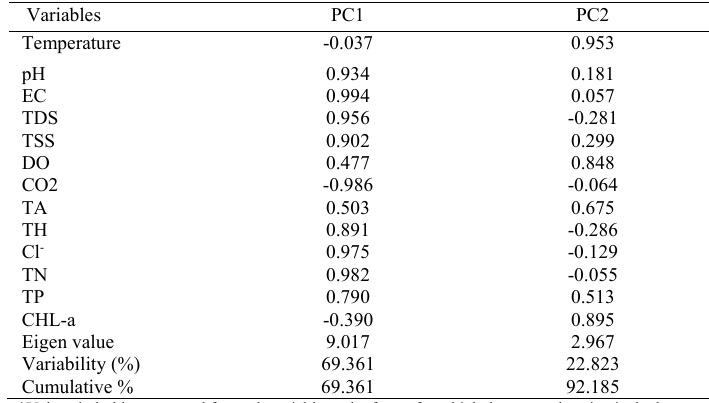
Table 3: Factor loading matrix (after varimax rotation), eigen values and variances for lake waters Variables